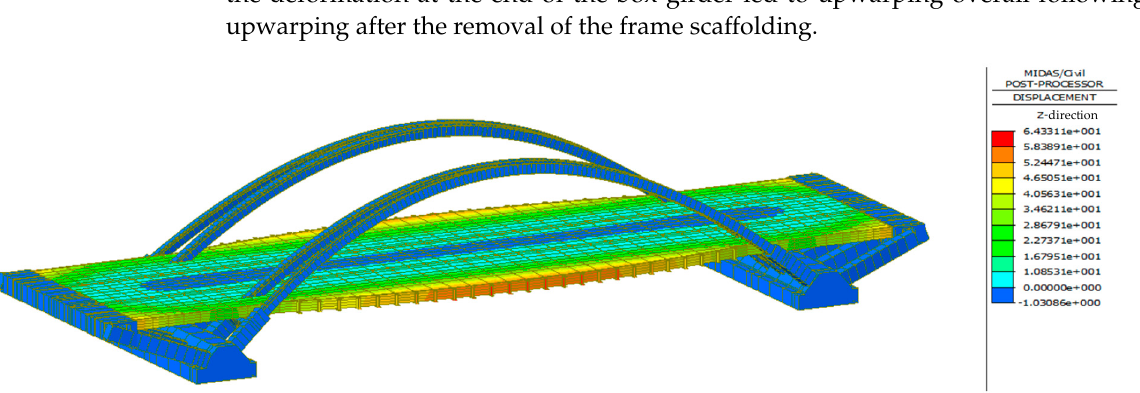
Figure 23. Deformation of the box girder after installation of the top plate (unit: mm).